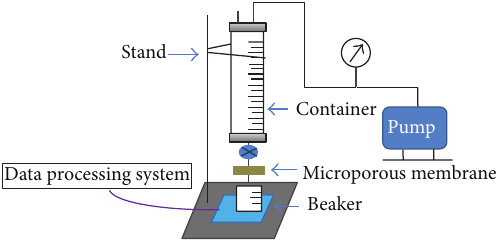
Figure 1: Apparatus of microporous membrane filtration.